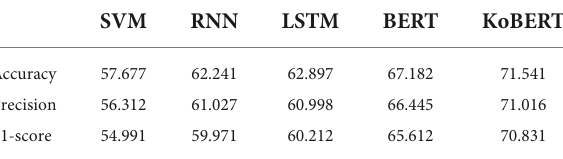
TABLE 4 Performance evaluation results of five sentiment classification